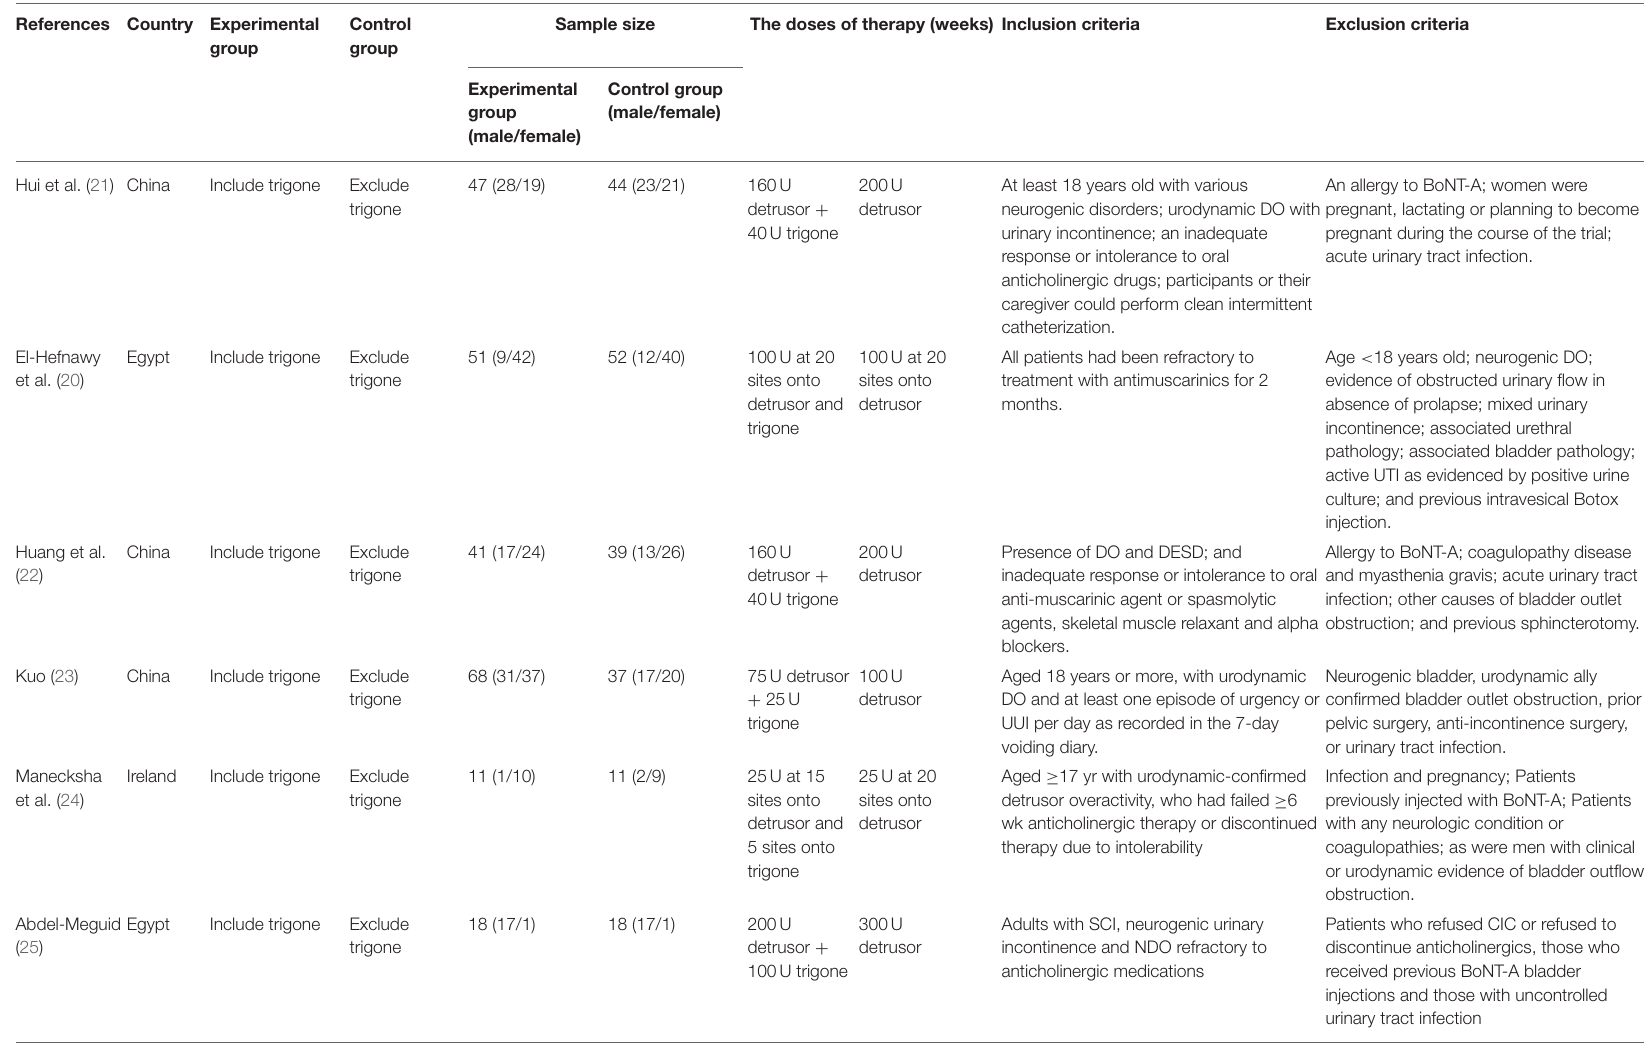
TABLE 1 | Study and patient